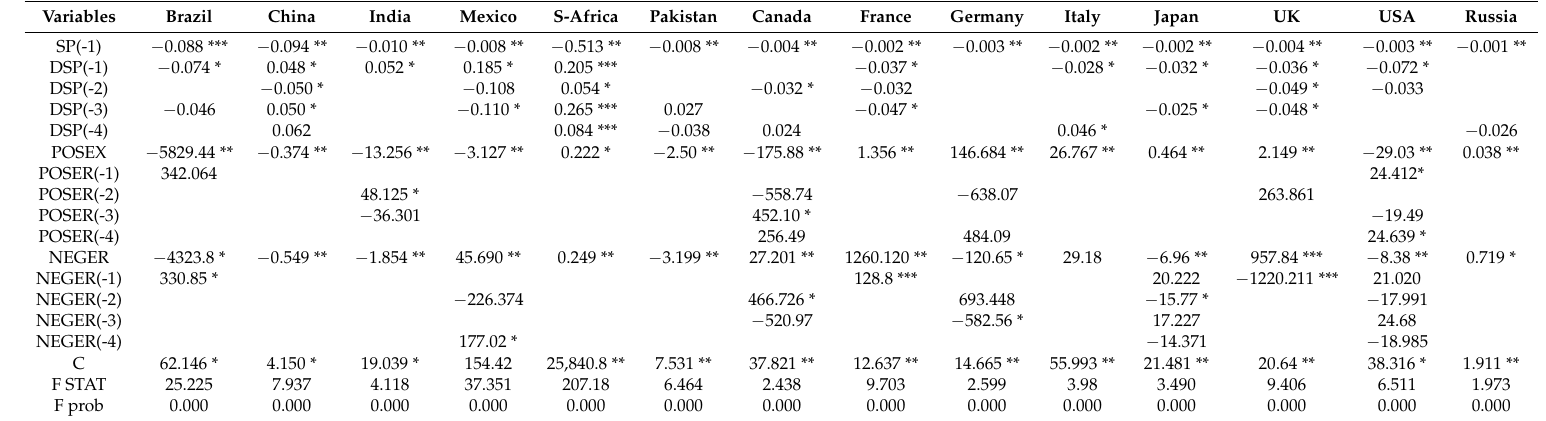
Table 6. NARDL dependent variable: stock